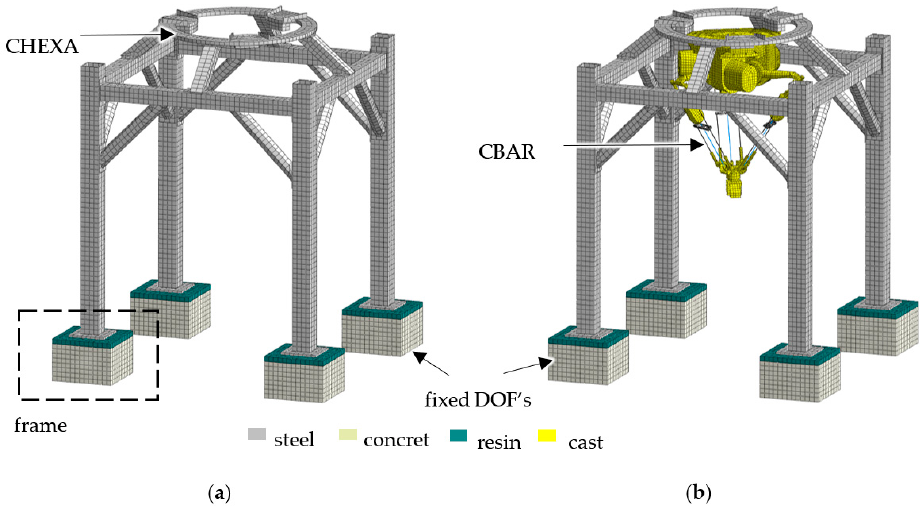
Figure 2. Finite element model of ( a ) the frame and ( b ) the frame with the robot.